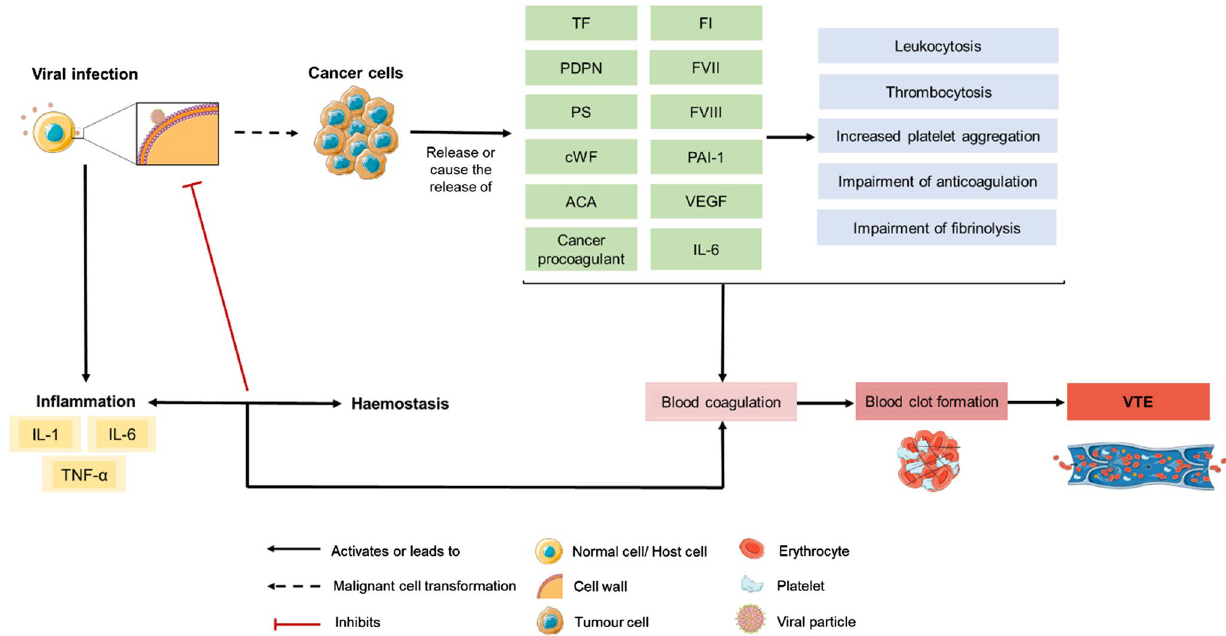
Fig. 2 Interplay between viral infection, tumorigenesis and VTE development. Tumour cells are known to cause a pro-thrombotic cascade that may lead to VTE development. Likewise, viruses, well-known oncogenic agents, can also trigger thrombogenesis through the estab- lishment of a pro-inflammatory state that can disrupt the haemostatic balance, given the close interplay between immunity and coagula- tion. ACA antiphospholipid anticardiolipin antibodies, cWF von Willebrand factor, FI fibrinogen, FVII coagulation factor VII, FVIII factor VIII, IL-1 Interleukin 1, IL-6 Interleukin 6, PAI-1 plasminogen activator inhibitor-1, PDPN podoplanin, PS phosphatidylserine, TF tissue factor, TNF- α tumour necrosis factor-alpha, VEGF vascular endothelial growth factor, VTE venous thromboembolism. The figure includes pictures